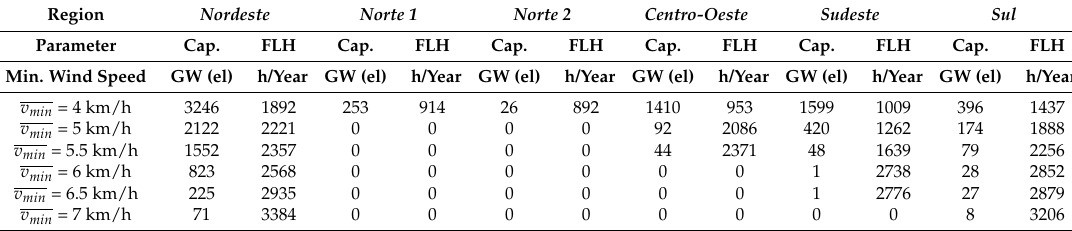
Table A7. Available onshore wind potentials at different average annual wind speeds, evaluated using REMix-EnDAT. Note that installable capacities are displayed in GW and annual full load hours in h/year.